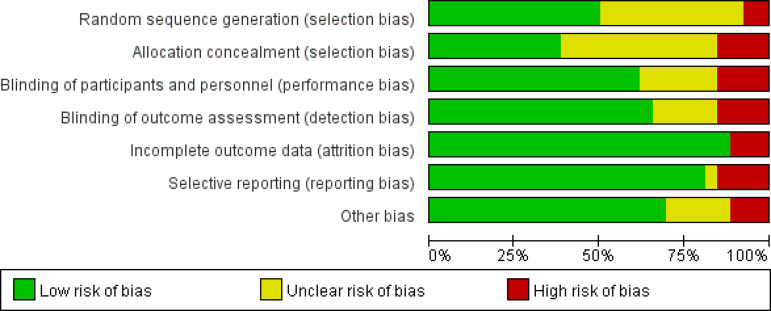
Document quality evaluation.